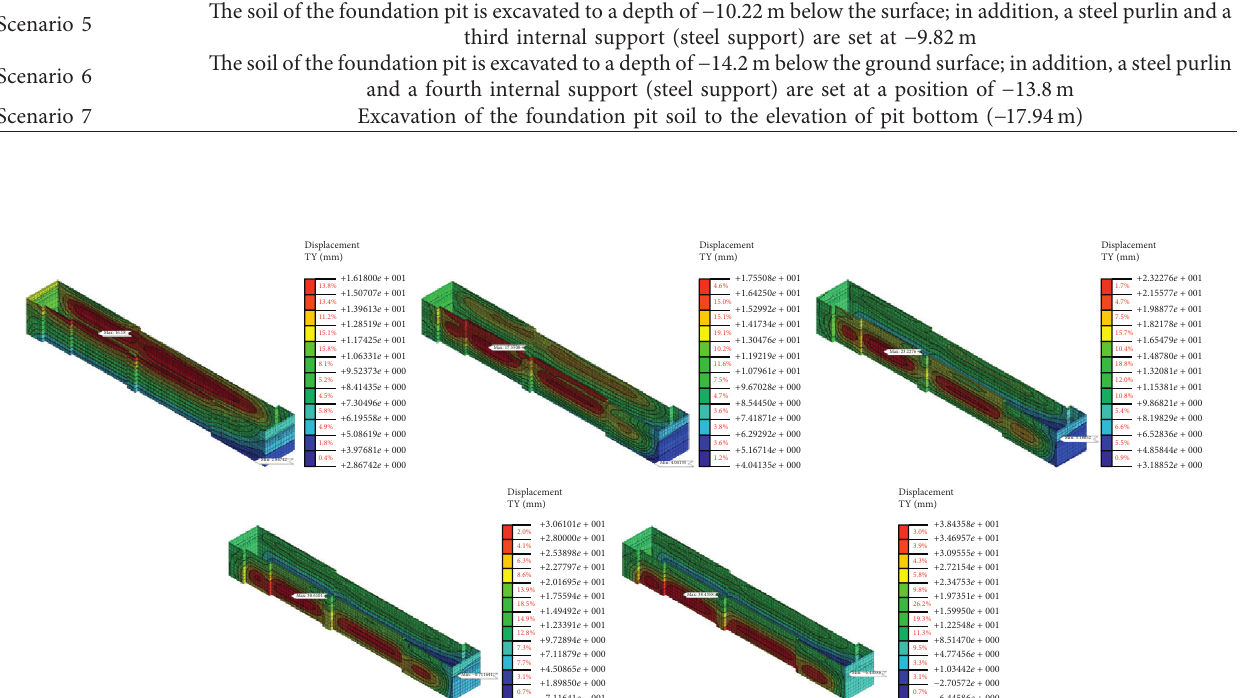
Figure 3: The horizontal displacement of the long side of the underground diaphragm wall in the Y -direction under each analysis condition.